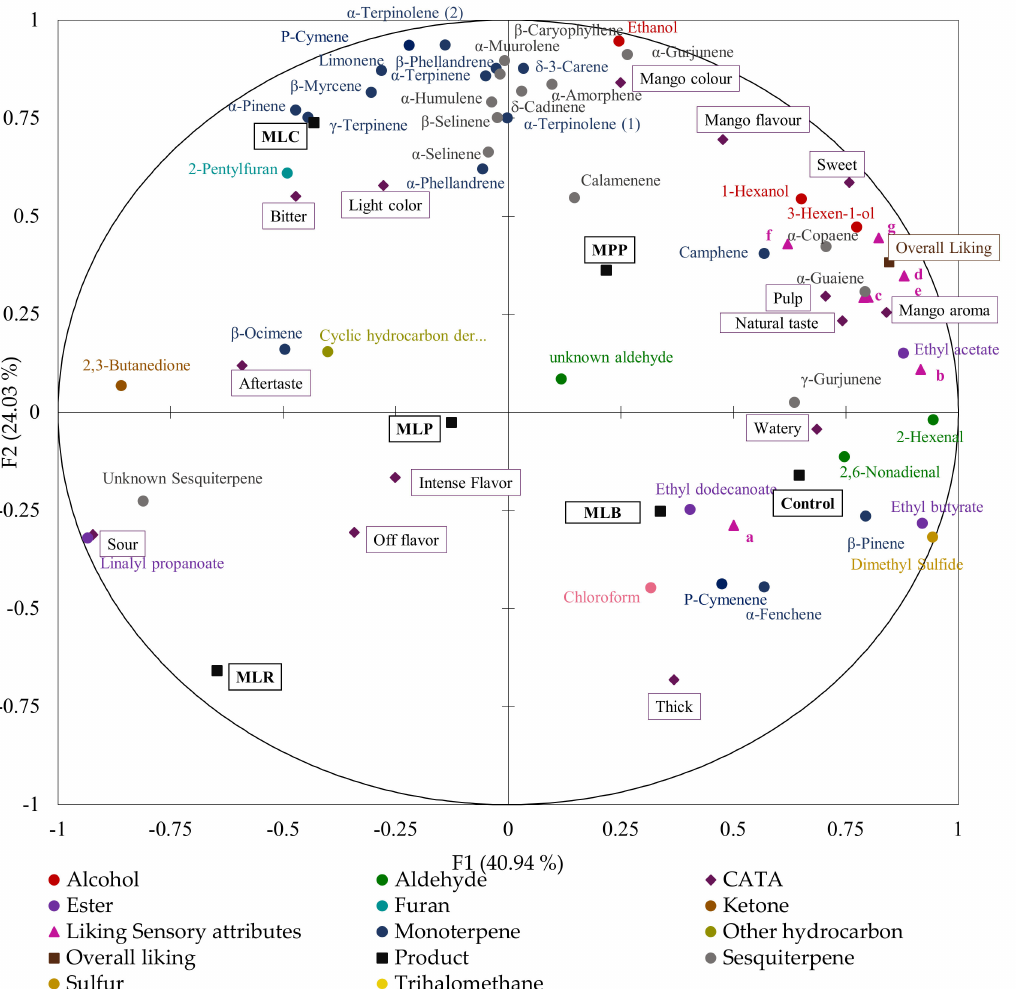
Figure 6. Multifactorial analysis (MFA) showing the relationship between the volatile compounds (ng/mL of 2-octanol equivalents), overall liking, liking of sensory attributes ratings, and CATA characterization. Mango juices fermented with MLB— Levilactobacillus brevis ; MLC— Lacticaseibacillus casei ; MLP— Lactiplantibacillus plantarum subsp. plantarum ; MLR— Lacticaseibacillus rhamnosus ; MPP— Pediococcus pentosaceus . Control is mango juice with no lactic acid bacteria under the same conditions of fermentation (24 h). Liking of sensory attributes, a = liking color, b = liking consistency, c = liking sweetness, d = liking flavor, e = liking aroma, f = liking appearance, and g = liking acidity. ( n =